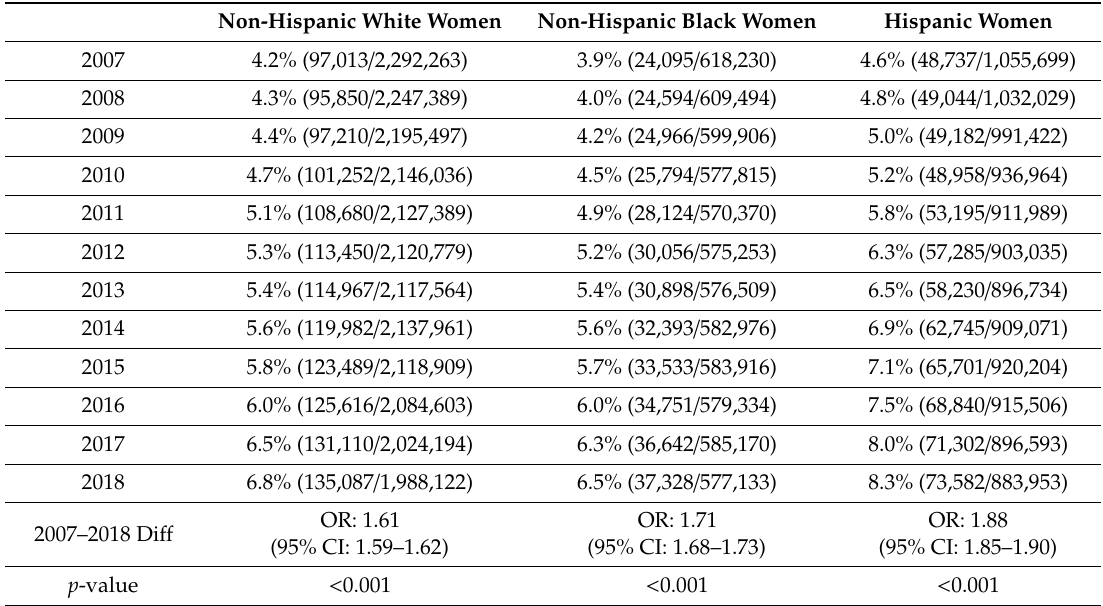
Table 3. Annual prevalence of diabetes mellitus (DM) for 2007–2018, by racial / ethnic group.